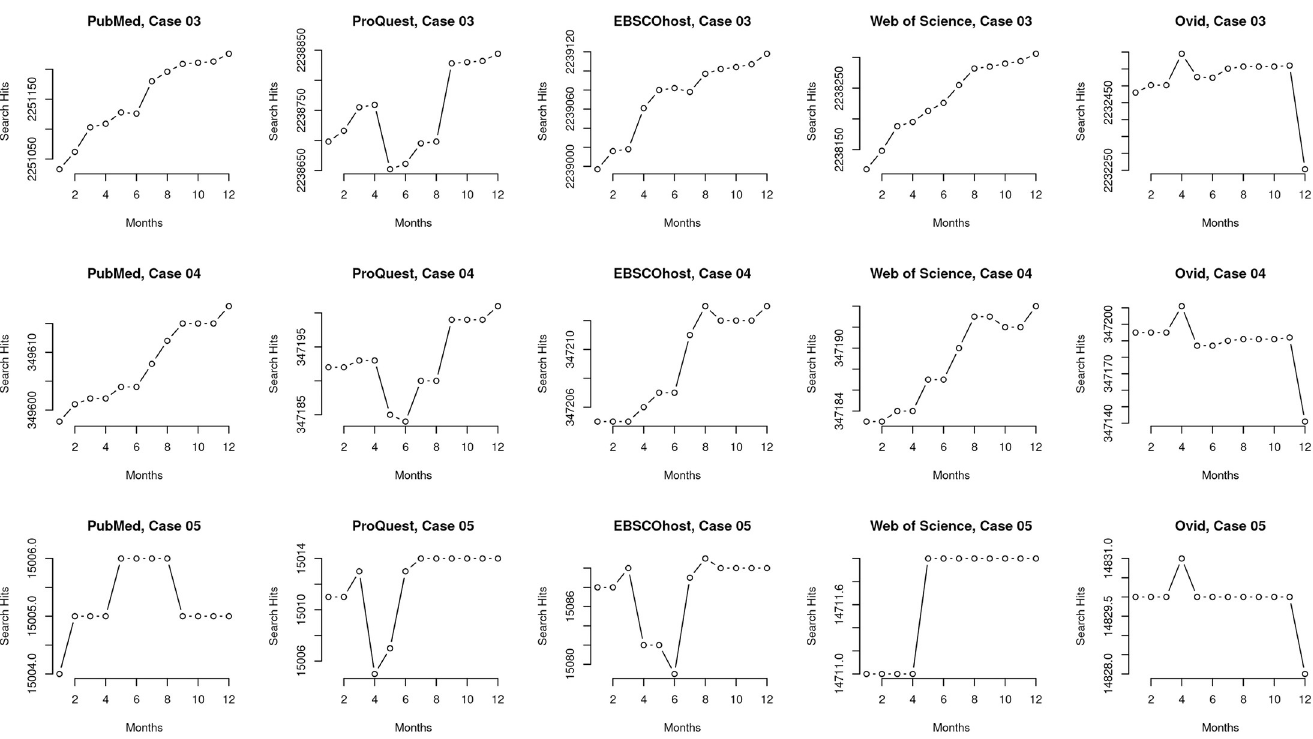
Fig 4. Micro view of cases #03–#11. A micro perspective of search result counts for cases #03-#11 that were restricted by publication date. Each row displays all five platforms individually within a case to aid side by side comparison of results. The micro perspective is able to show how the platforms vary in detail and trends; most importantly, they highlight different trajectories and differences in how platforms drop retrieved records even for publications with publication dates ending years before data collection.